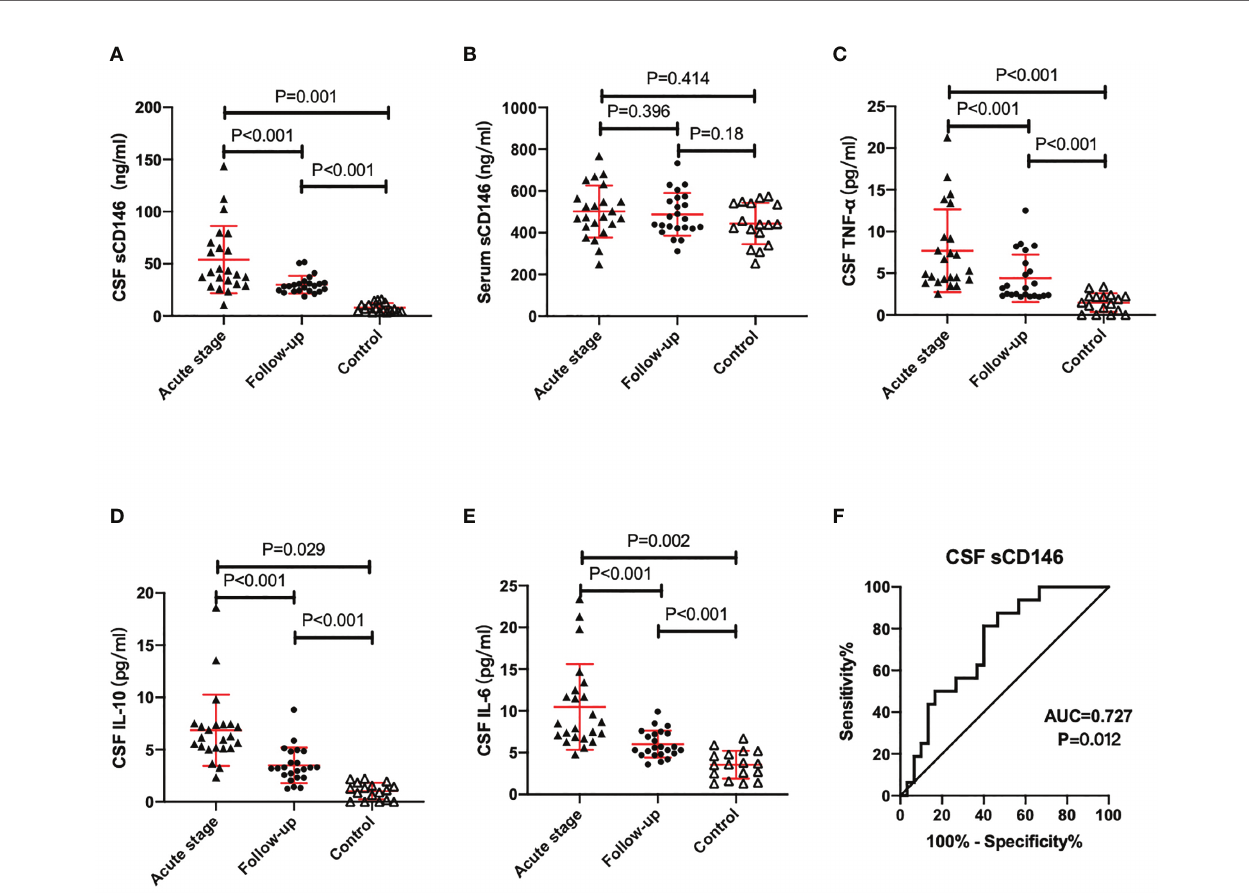
FIGURE 1 | sCD146 levels in the CSF of patients with acute stage anti-NMDAR encephalitis were signi fi cantly increased compared with controls and 3-month follow-up accompanied by increases in TNF- a , IL-6 and IL-10 (A – E) . The ROC curve of CSF sCD146 to predict the severity of neurologic impairments in anti- NMARD encephalitis patients (F)